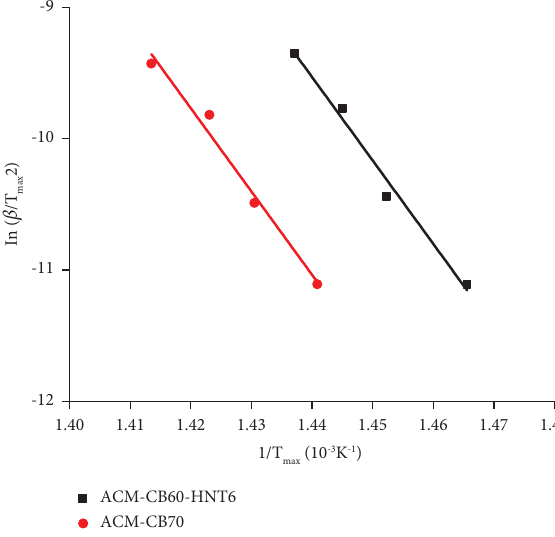
Figure 8: Kissinger plot applied to TGA data of ACM composites at diferent heating Table 4: Activation energy ( E a ) calculated following the Kissinger method.